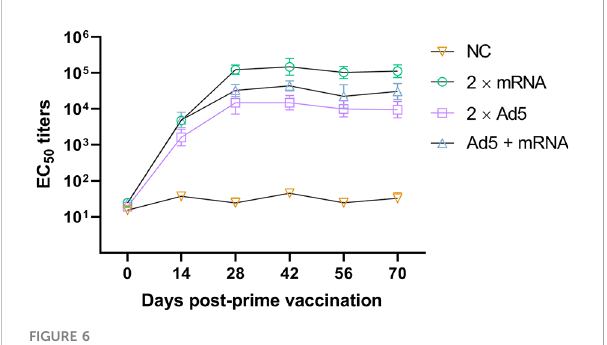
FIGURE 6 Neutralizing antibody responses to different immunization regimens.